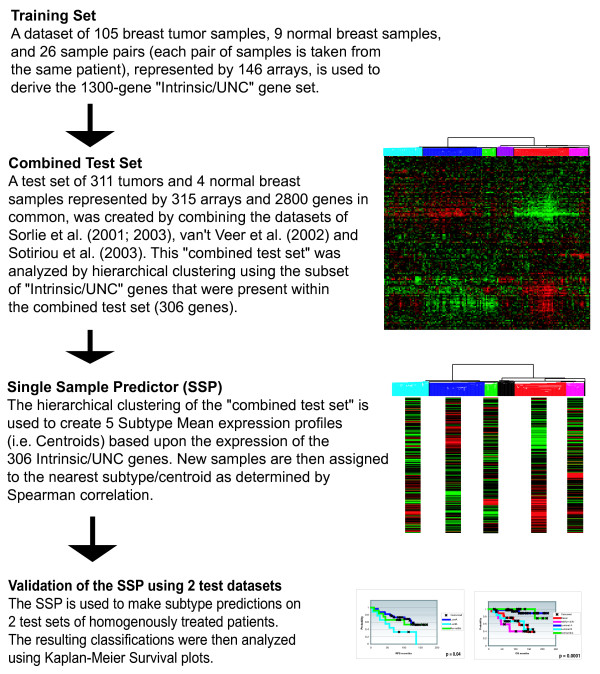
Overview of the analysis methods and datasets used in this paper.